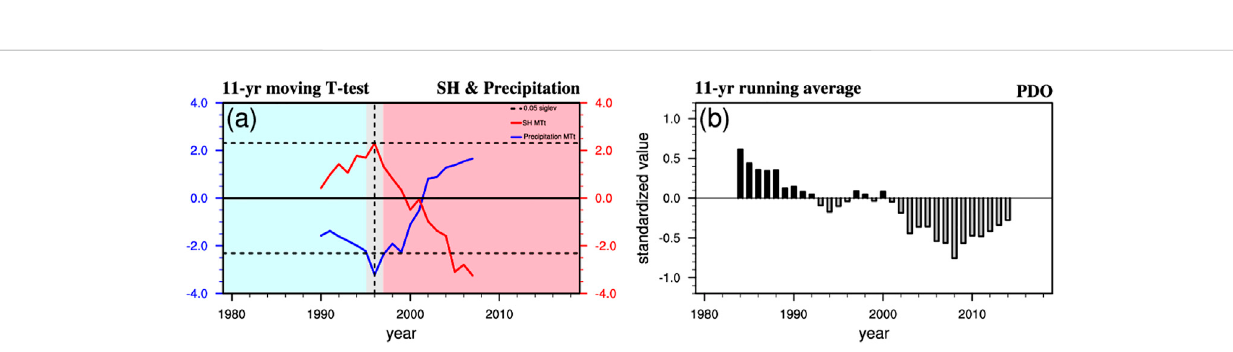
FIGURE 8 (A) Eleven-yearsliding t - test ofthespringSHovertheTPandmidsummerprecipitationinSouthChina.Solidredandblacklinesrepresentthespring SH over the TP and the midsummer precipitation in South China, respectively, and dashed lines indicate the 95% signi fi cance level. (B) Eleven-year moving average of the PDO index.